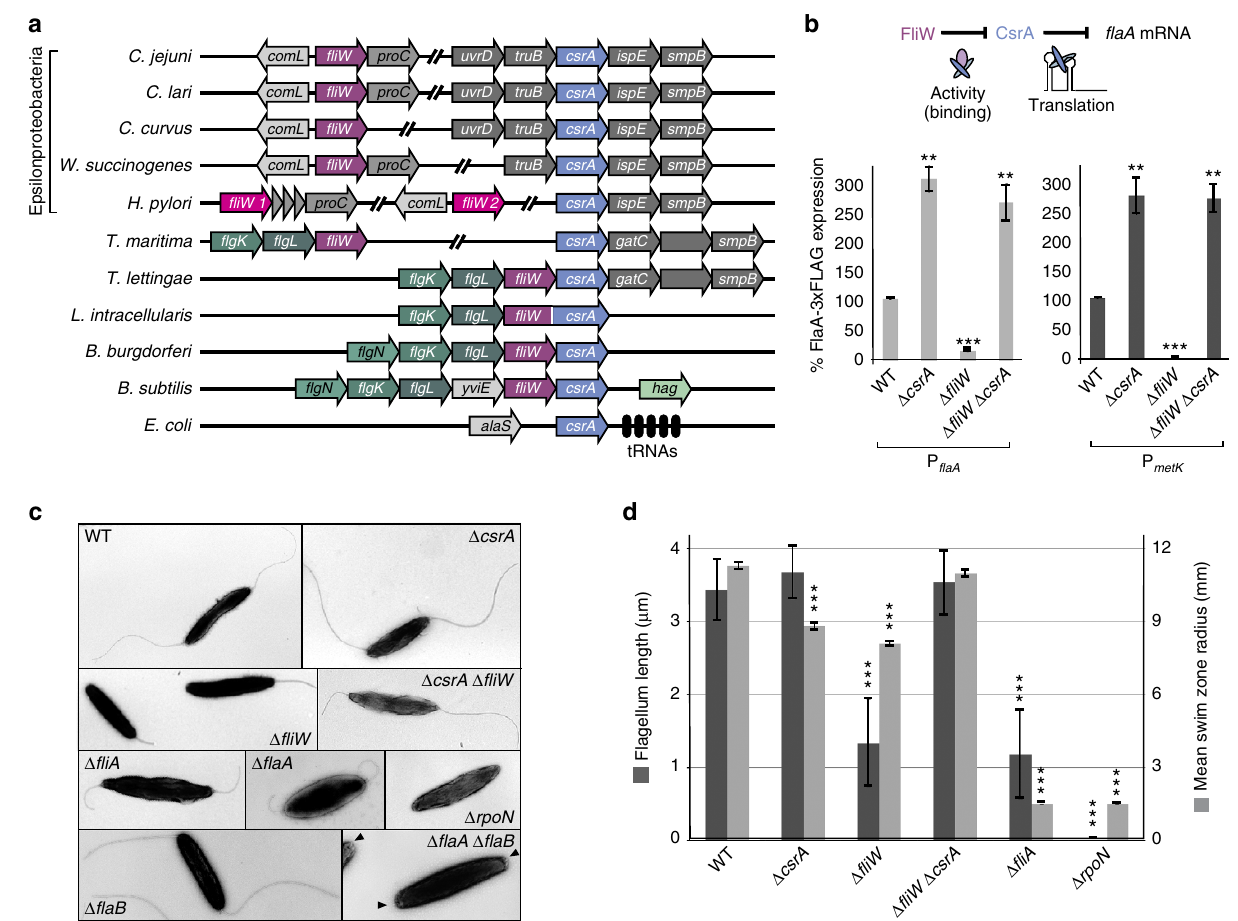
Figure 3 | The flagellar assembly factor FliW binds and antagonizes CsrA. ( a ) Genomic context of csrA and fliW homologues in diverse bacterial species ( Campylobacter spp: C. jejuni, C. lari, C. curvus ; Wolinella succinogenes ; Helicobacter pylori ; Thermotogales: T. maritima, T. lettingae ; Lawsonia intracellularis ; Borrellia burgdorferi ; Bacillus subtilis ; Escherichia coli ). Blue: csrA homologs; dark or light red: fliW homologues; shades of green: flagellar genes. ( b ) (Top) Scheme of the antagonizing effect of FliW on CsrA-mediated translational repression of flaA mRNA by direct binding of FliW to CsrA. (Bottom, left) Quantification of FlaA-3xFLAG using western blot in C. jejuni WT, D csrA , D fliW and D csrA / D fliW strains in mid-log phase ( n ¼ 3 biological replicates). Plotted is the mean ± s.e.m (** P o 0.01, *** P o 0.001 using Student’s t -test). (Bottom, right) Quantification of FlaA-3xFLAG using western blot in WT, D csrA , D fliW and D csrA / D fliW strain backgrounds where the flaA promoter has been exchanged with the constitutive metK promoter. Please note that FlaA- 3xFLAG levels expressed from the P metK promoter represent B 70% compared with the expression from its native P flaA promoter. ( c ) Transmission electron micrographs of indicated strains harvested from MH agar. Black triangles indicate hook structures. ( d ) Average flagella length (dark grey bars) of indicated strains from transmission electron micrographs using ImageJ ( n 4 25 measurements). Plotted is the mean ± s.d. (*** P o 0.001 versus WT using Student’s t -test). Motility was measured as average swimming distance (light grey bars) in soft agar. Bars show the mean ± s.e.m (*** P o 0.001 versus WT using Student’s t